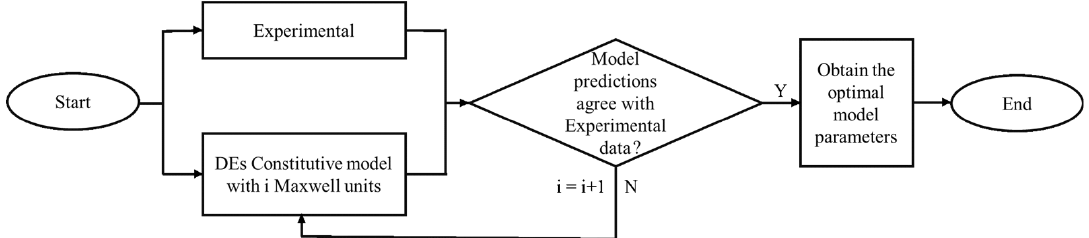
Figure 1. Research Flowchart of dielectric elastomers (DE).